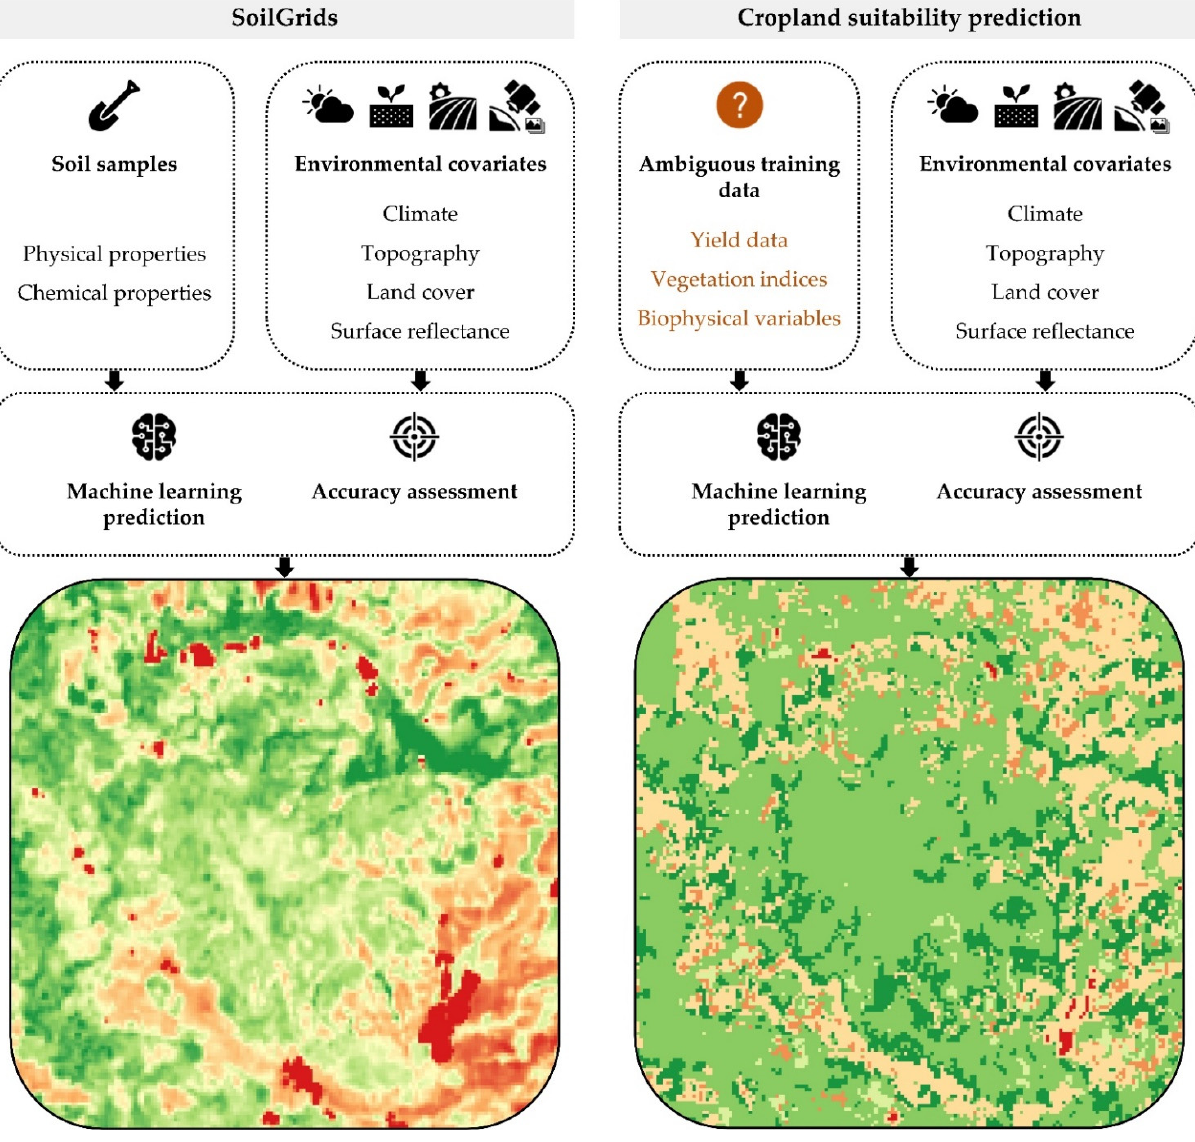
Figure 2. Conceptual comparison of the machine learning prediction approach implemented in SoilGrids [16] and for cropland suitability calculation.